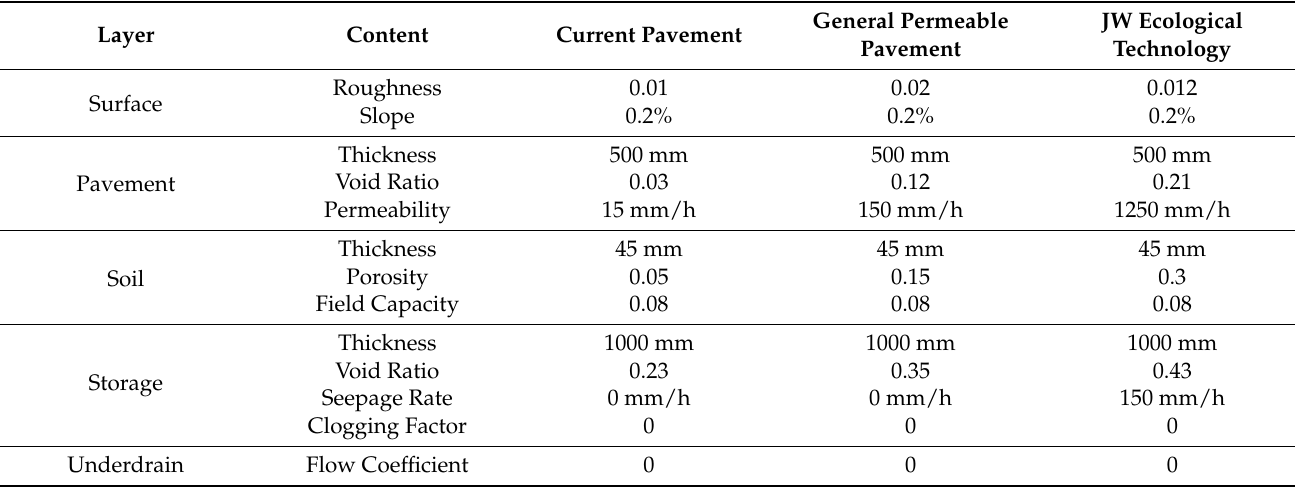
Table 1. The vertical construction parameters of the different impermeability